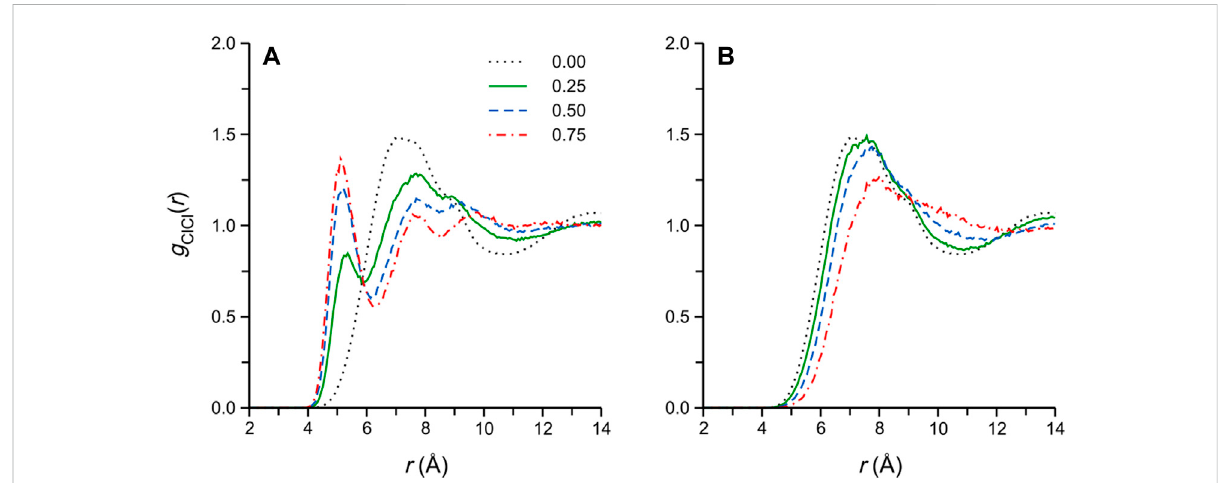
FIGURE 5 Cl − -Cl - RDFs of selected (A) DES/water and (B) DES/methanol simulated systems. The numbers in the legend in (A) refer to the cosolvent mole fraction, and applies to both